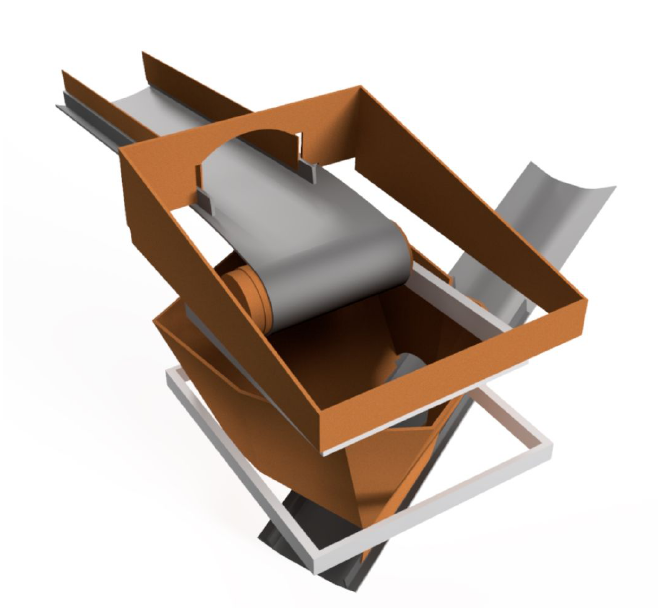
Figure 7. CAD model of the transfer